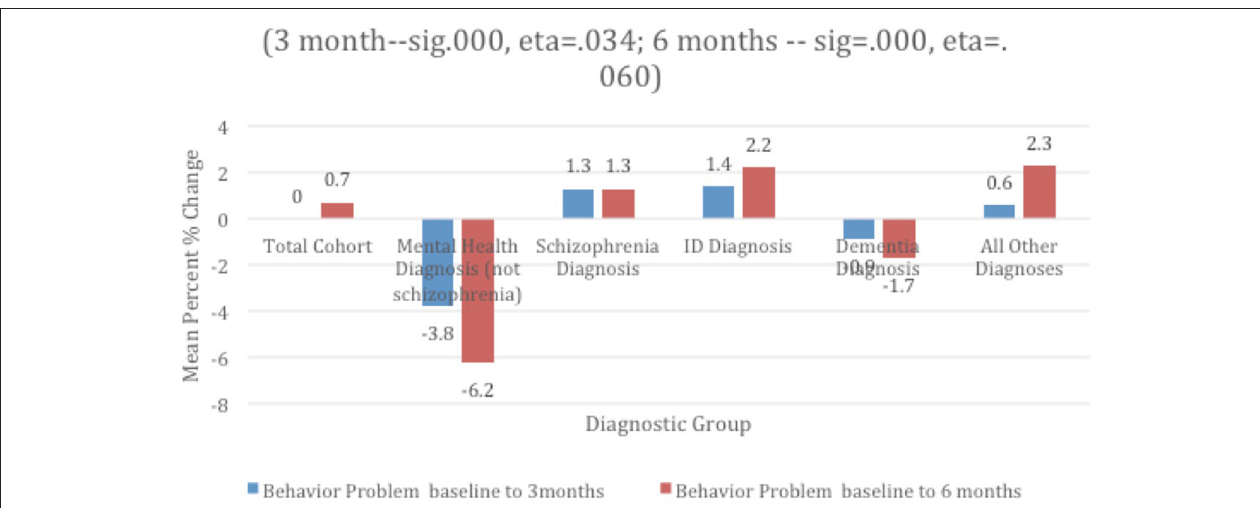
FIGURE 3 | Mean % change in problem behavior over time and by diagnostic